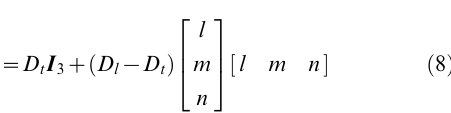
Figure 3. Comparison of action potential waveforms in the SAN, right atrium, inferior nodal extension and penetrating bundle in simulations (left) and experiment (right). Experimental recordings from Kodama et al. [95] (SAN) and de Carvalho and de Almeida